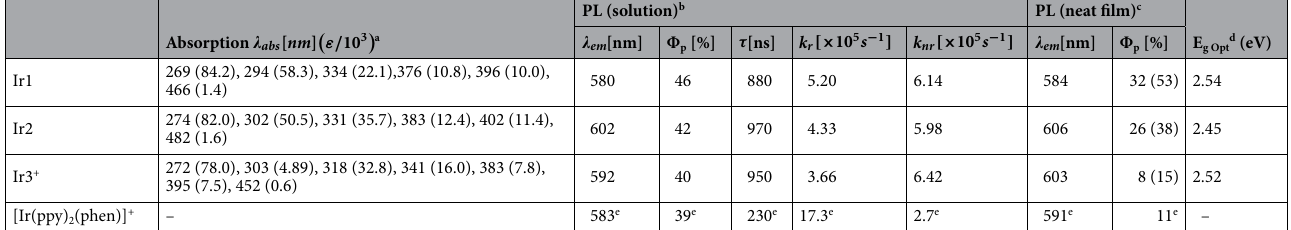
Table 1. Photophysical data for Ir1, Ir2, and Ir3 + . a In air-equilibrated CH 3 CN at 298 K (10 −5 M). b In degassed CH 3 CN at 298 K (10 –5 M); the emission quantum yields (Φ p ) were calculated by comparison with quinine sulfate (Φp = 0.545 in 1 M H 2 SO 4 (estimated error of ± 5%.); Lifetime were calculated based on a mono- exponential decay model. k r and k nr were calculated based on the equations τ = 1/ (k r + k nr ) and Φ p = k r / (k r + k nr ). c Solid-state absolute quantum yield was measured by employing an integrating sphere system (estimated error: ± 5%), Values in parentheses were obtained for films with a composition similar to LEC (iTMC:IL, 4:1). d Optical bandgap, from the intersection of absorption and emission spectra. e Data from Ref. 59 .